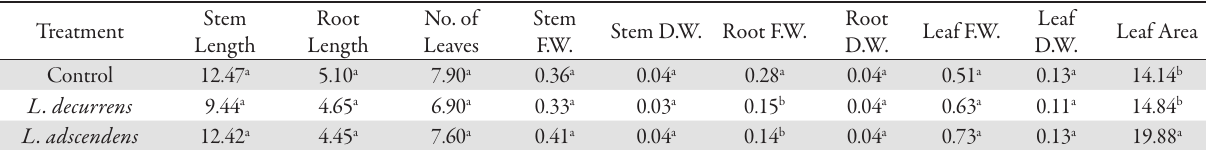
Tab. 3. Effect of Ludwigia decurrens and L. adscendens exudates on vegetative parameters of Corchorus olitorious at week 5 Treatment